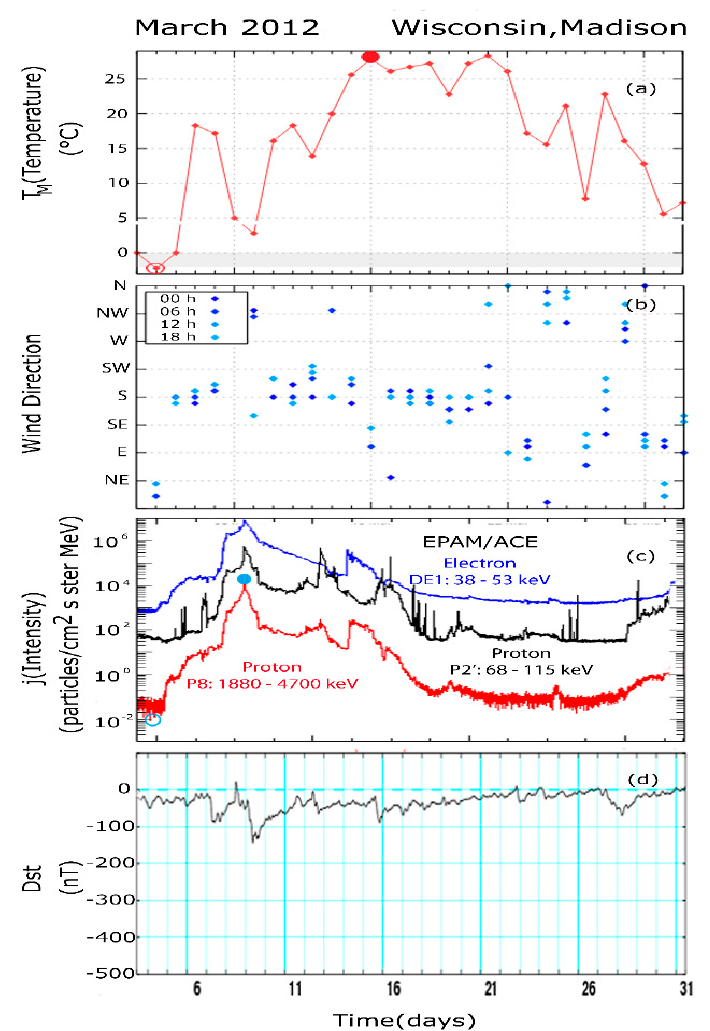
Figure 3. Time profiles of temperature T M in Madison, Wisconsin ( a ), the direction of wind in the same town ( b ), the fluxes of energetic protons and electrons observed by the ACE spacecraft and ( c ) and ( d ) the values of the geomagnetic index Dst, during 3–30 March 2012. During an ICME- induced SEP event (flux increase during 4–20 March), the temperature remained at very high levels for an unusually long time in March, i.e., at a level of ≈ 23–28 °C for one week (15–22 March) or above a level of 16 °C for about two weeks (11–25 March) and with a general temperature in ‐ crease as high as ΔΤ = +30 °C within 10 days ( a ). The high temperatures were recorded during time periods with surface air streaming from the southward direction (( b ); S wind direction). Proton events on days 7–9, 11–12 and 13–15 March 2012 (thereafter called SEP1 ‐ 2, SEP3, and SEP4) are associated (orange lines in Figure 3) with four magnetic storms with extreme low geomagnetic values Dst on days March 7, 9, 12 and 15 (panel d). Tsurutani et al. [79] investigated in detail these storms, which were called S1, S2, S3, and S4 (this naming was followed by [80] and is used thereafter in the present study; in a similar study, S1 and S2 st ο rms coincide with the onset of the SP1 ‐ 2 event and its accelerating IP